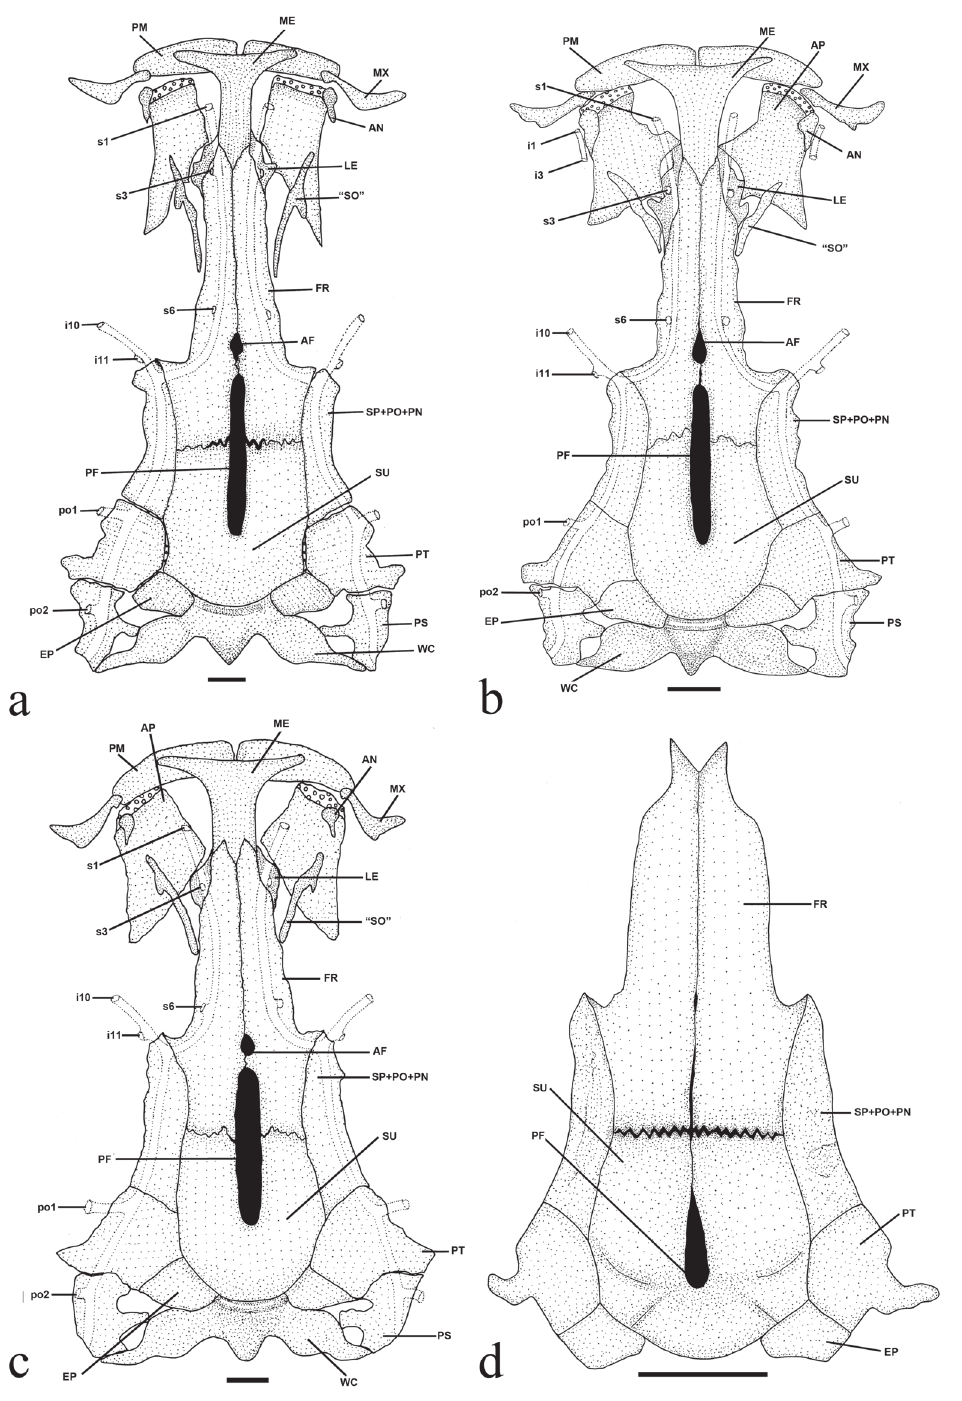
Fig. 2. Dorsal view of neurocranium of ( a ) Trichomycterus balios , paratype, UFRGS 6831, 81.7 mm SL; ( b ) T . diatropoporos , paratype, UFRGS 16237, 57.8 mm SL; ( c ) T . poikilos , paratype, MCP 22699, 79.0 mm SL, and ( d ) T . brachykechenos , paratype, UFRGS 16245, 41.9 mm SL, some elements not shown. Abbreviations: AF, anterior fontanel; AN, antorbital; AP, autopalatine; EP, epioccipital; FR, frontal; LE, lateral ethmoid; i1, infraorbital sensory branch 1; i3, infraorbital sensory branch 3; i10-11, infraorbital sensory branch 10 and 11; ME, mesethmoid; MX, maxilla; PF, posterior fontanel; PM, premaxilla; po1-2, postotic sensory branches 1 and 2; PS, posttemporosupracleithrum; PT, pterotic; s1, supraorbital sensory branch 1; s3, supraorbital sensory branch 3; s6, supraorbital sensory branch 6 (epiphyseal branch); SO, tendon-bone supraorbital; SP+PO+PN, sphenotic- prootic-pterosphenoid complex bone; SU, parieto-supraoccipital; WC, Weberian capsule. Scale bar = 2